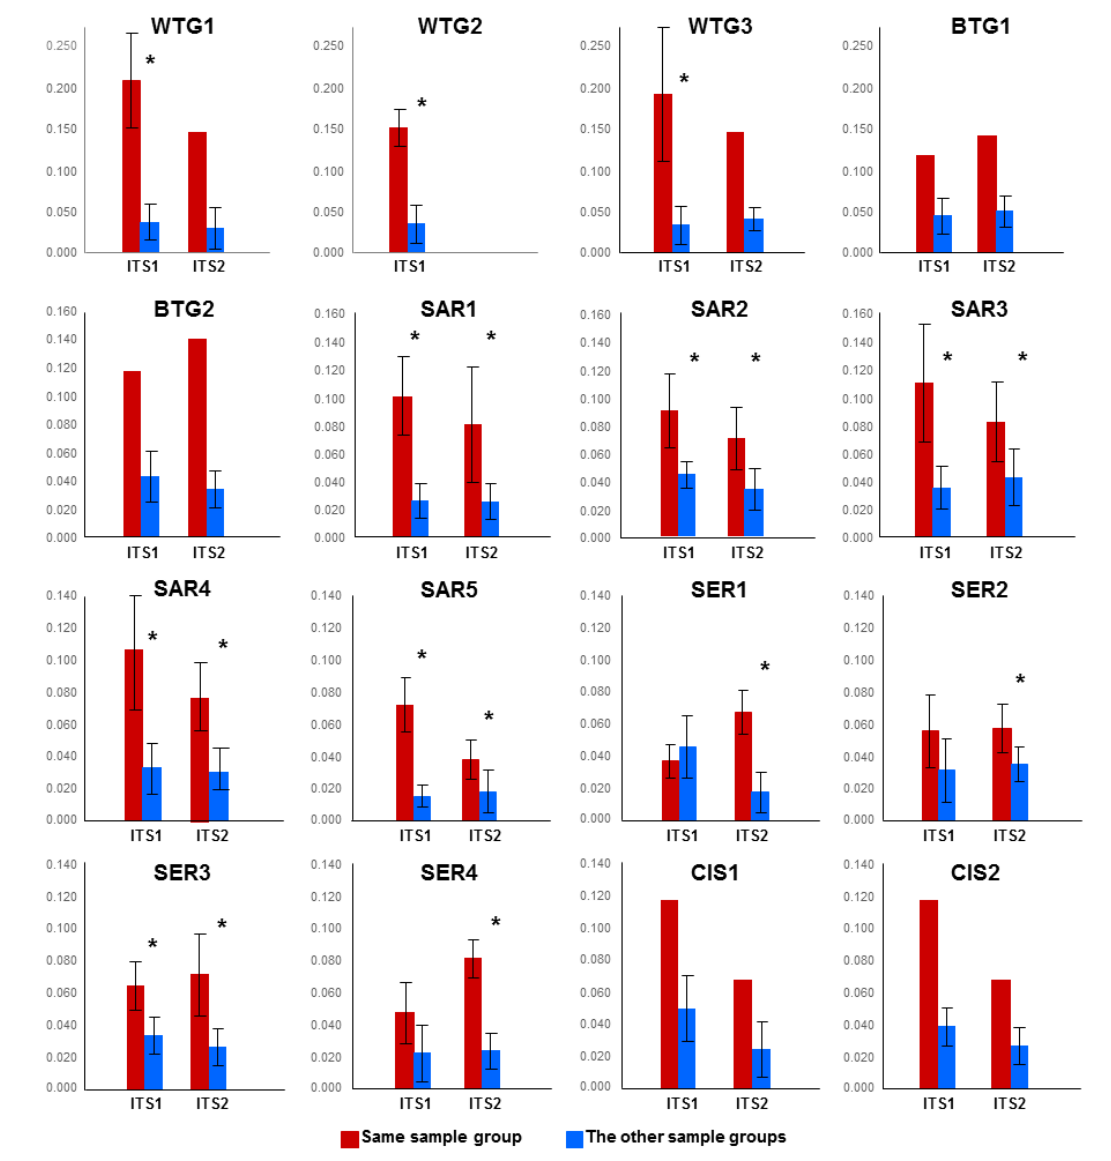
Figure 3. Pairwise Jaccard similarity indices between fungal communities from the same sample group or the other groups. For both ITS1 and ITS2, Jaccard indices were computed following rarefaction to 150 sequences per sample for both ITS1 and ITS2, to compare each fungal community with each of the other fungal communities from either the same sample group (blue columns) or the other groups (red columns). Mean values (columns) and standard deviations (bars) are reported for each comparison. Couples of columns marked with an asterisk indicate a significant difference between indices computed for intra-group pairwise comparisons and indices computed for inter-group pairwise comparisons ( p < 0.05; Kruskal-Wallis